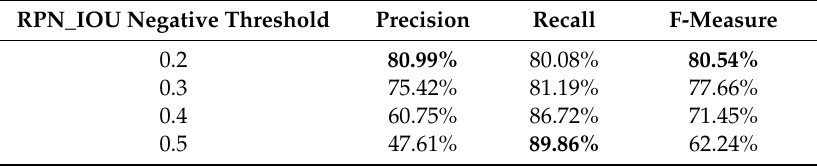
Table 4. The results with the different RPN_IOU negative thresholds.